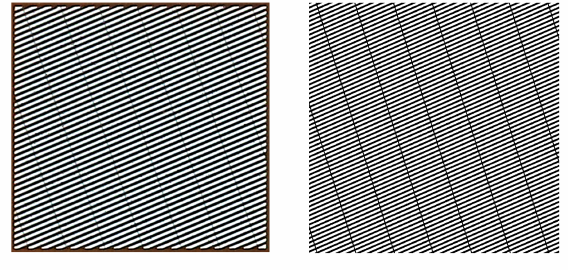
Figure 2. Left panel: Photograph of STIX grid No. 1 (numbers conven- tion according to Krucker et al. (2020)) with pitch equal 77.7 µm . The different size of slits and slats is visible. Moreover, bridges sup- porting slats are seen as narrow lines perpendicular to slats. Right panel: Monte Carlo simulation of the same grid (see Paragraph 3 for details).